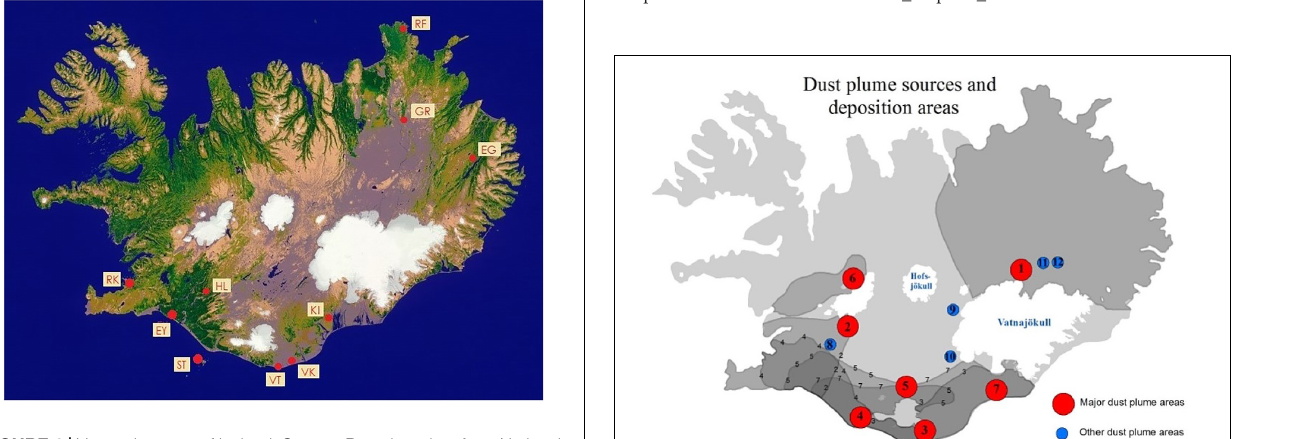
Frontiers in Earth Science |